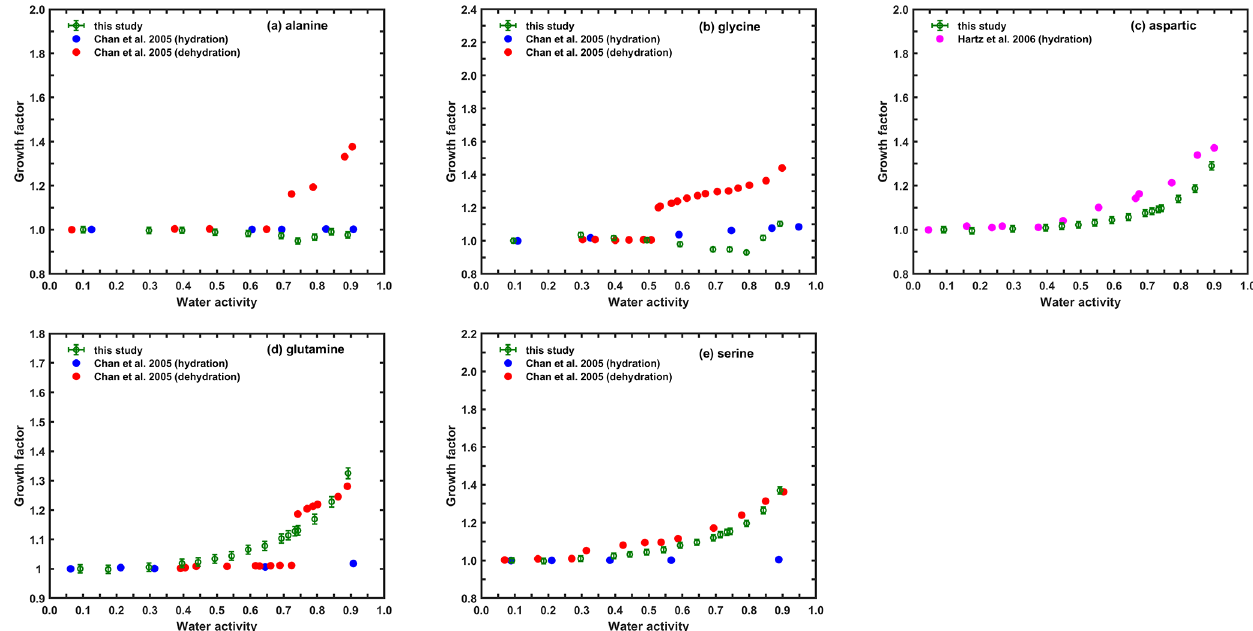
Figure 3. Hygroscopic growth factors of amino acids and comparison with previous studies.